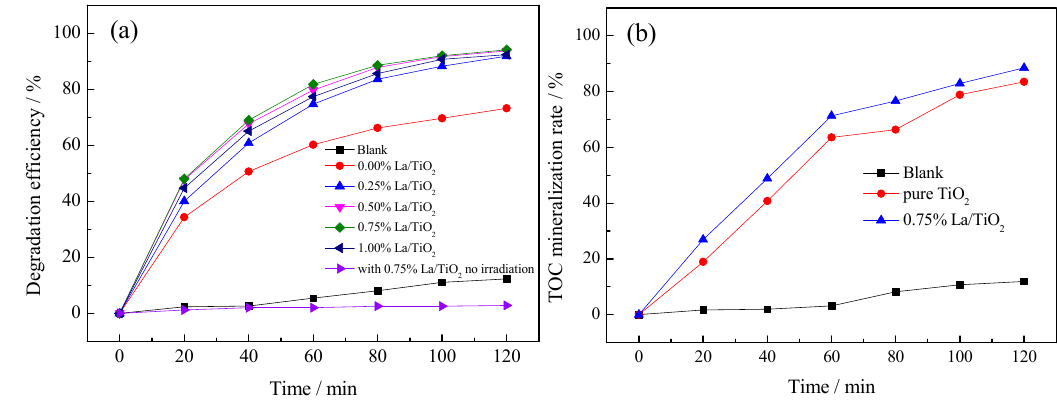
Figure 6. ( a ) Effect of different La doping ratio on the photodegradation of benzohydroxamic acid by La/TiO 2 ; ( b ) TOC mineralization rates of 0.75% La/TiO 2 , pure TiO 2 and blank. Reaction conditions: C (benzohydroxamic acid) = 30 mg·L − 1 , C (catalyst dosage) = 0.3 g·L − 1 , 300 W mercury lamp, calcined temperature at 500 °C.